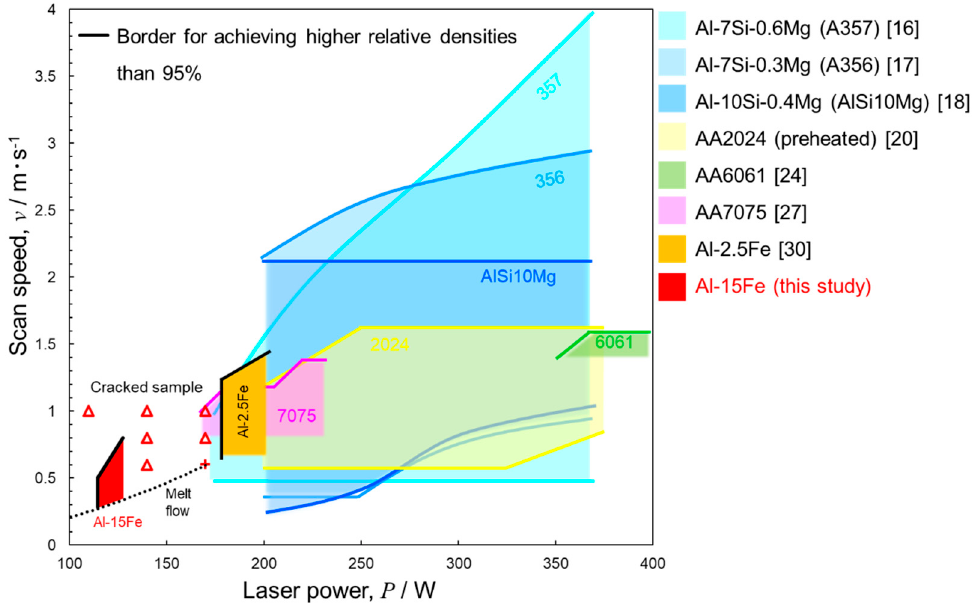
Figure 8. Laser power ( P ) and scan speed ( v ) for manufacturing the Al–15%Fe alloy samples with high relative densities above 95%, together with the process windows for manufacturing other alloy samples reported in the literature [16–18,20,24,27,30].